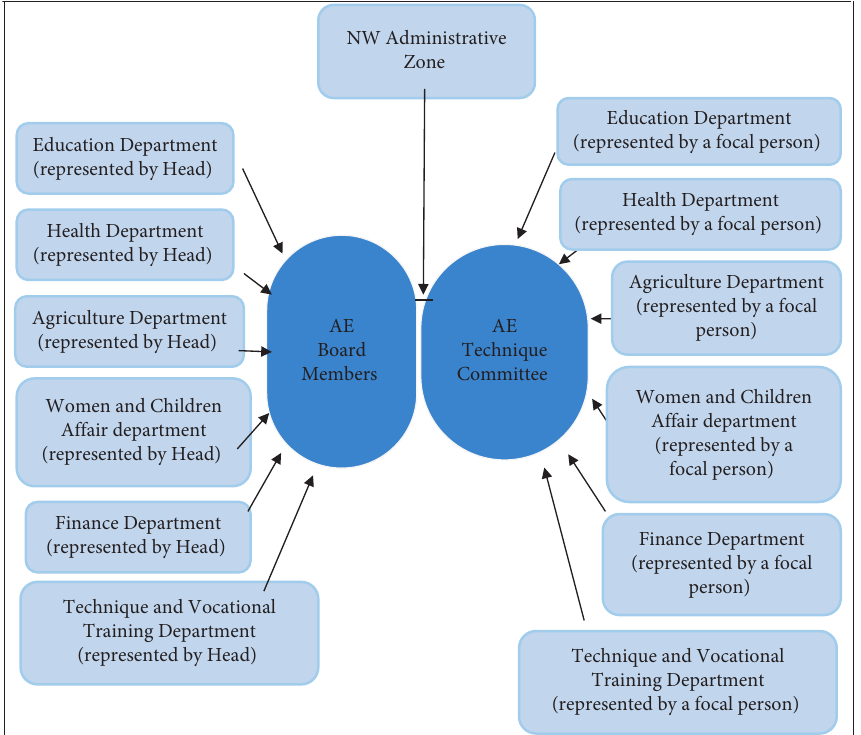
Figure 1: NW zone AE administration